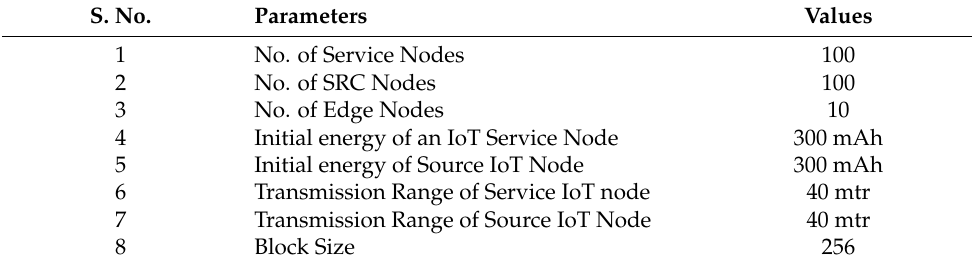
Table 7. Simulation